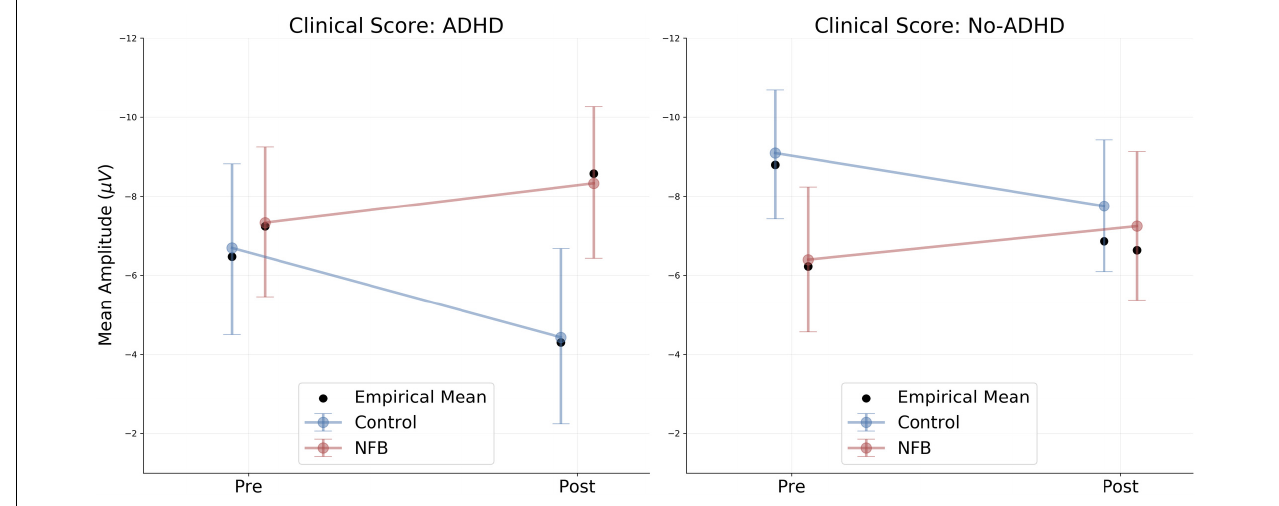
FIGURE 3 | Binary moderator model results. Model-based predictions of population-level CNV amplitudes across both levels of the binary moderator. Colored points indicate predicted means. Red, Neurofeedback Group (NFB); Blue, Control Group. Black points indicate empirical means. Notice the difference between predicted and observed means due to shrinkage. Error bars indicate 95% credibility intervals (predictive uncertainty).